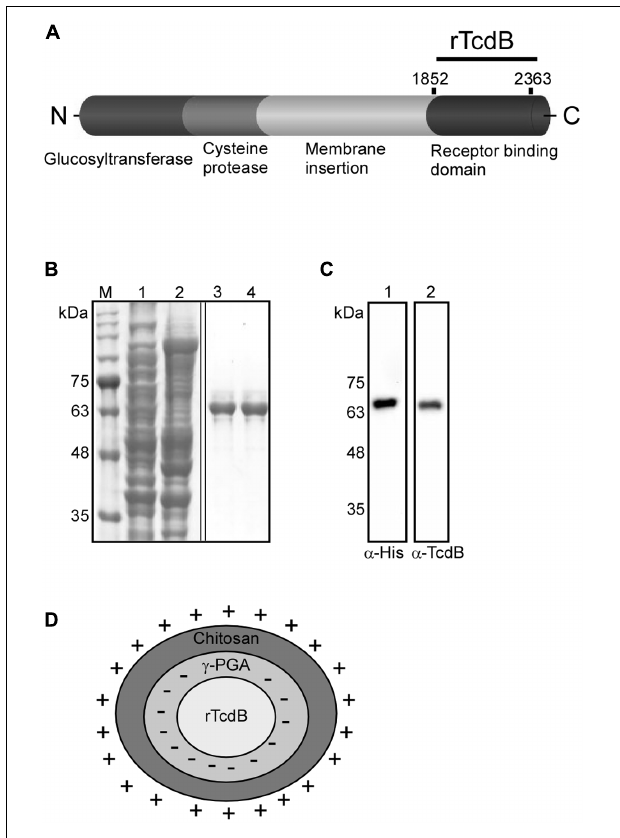
FIGURE 1 | Purification of recombinant TcdB and the composition of NP-rTcdBs. (A) Functional domains of TcdB and regions included for nanoparticle vaccine construction. (B) Coomassie blue staining of purified rTcdB. rTcdB were purified from E. coli by His-tag affinity chromatography. Lanes 1 and 2: Total E. coli lysates containing rTcdB and unbound proteins. Lanes 3 and 4: Purified rTcdB with. (C) Immunoblotting confirmation of rTcdB. M. Protein markers. rTcdB from SDS-PAGE was transferred to a membrane and detected by anti-His (lane 1) and anti-TcdB (lane 2). (D) Composition of NP-rTcdBs. The ionized chitosan and γ –PGA were able to form polyelectrolyte complexes via electrostatic interactions, resulting in a matrix structure with a spherical